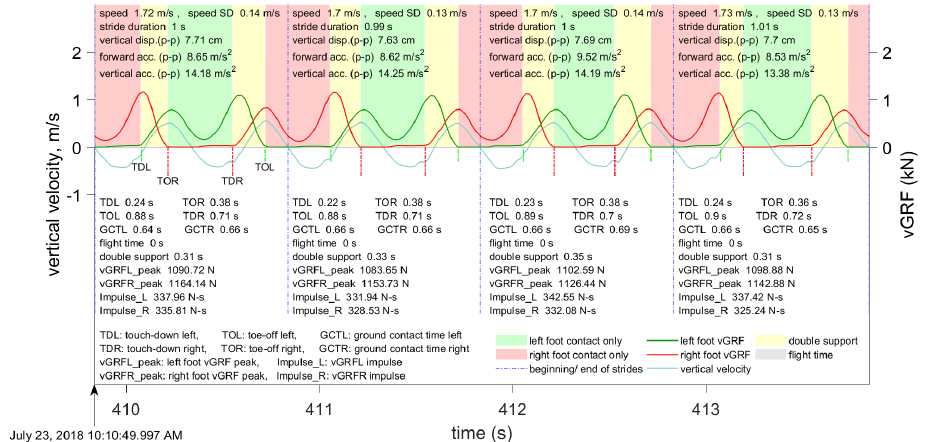
Figure 3. Example of the data computed by the INS/GPS and Moticon insoles during walking.